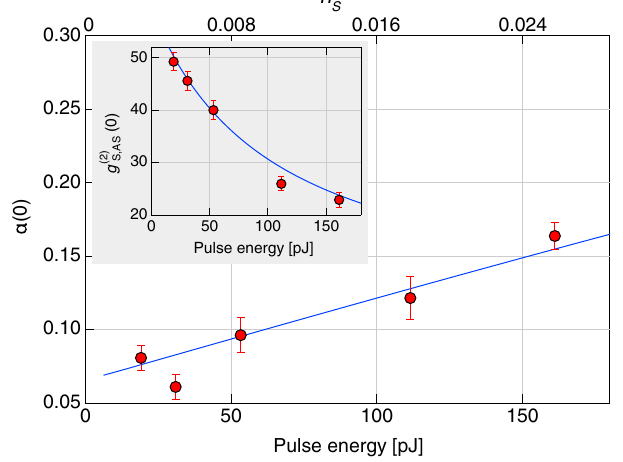
FIG. 3. Sub-Poissonian anti-Stokes statistics. Dependence of the heralded vibrational statistics on the write pulse energy and on the corresponding estimated probability of creating at least one ¼ ½ p= ð 1 − p Þ(cid:2) . The normalized Stokes photon per pulse, n S Stokes – anti-Stokes correlations are shown as an inset. The write-read pulse delay is fixed at zero and the read pulse energy at 322 pJ. Statistical error bars are obtained from the square root of the total number of events. Blue lines are models (see Supplemental Material, Sec. V[42]), using the estimated detec- tion efficiency (10%) and a relative efficiency of the read process (relative to the Stokes emission cross section) of 30% as the only two adjustable parameters (common to both